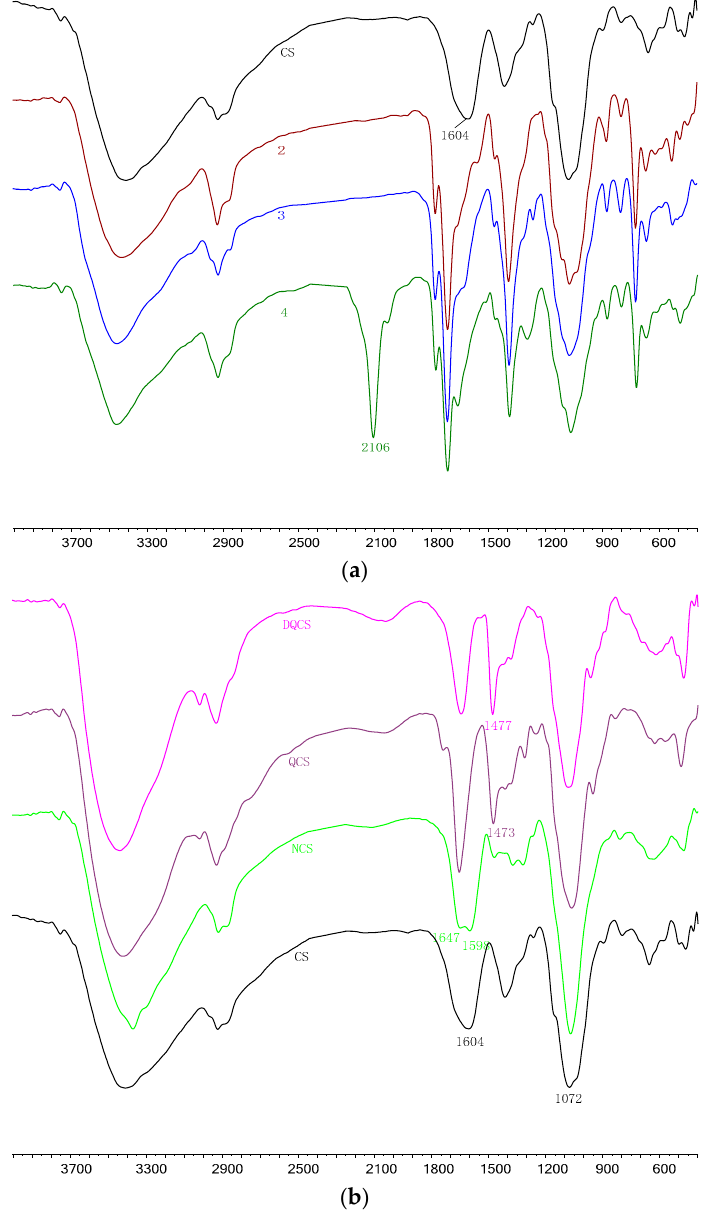
Figure 1. ( a ) FTIR spectra of the chitosan (CS), phthaloylation of chitosan (2), 6-bromo-6-deoxy- N - phthaloyl-chitosan (3), 6-azido-6-deoxy- N -phthaloyl-chitosan (4). ( b ) IR spectra of the chitosan (CS), 6-amino-6-deoxychitosan (NCS), N -quaternized chitosan (QCS), and N -diquaternized chitosan (DQCS).